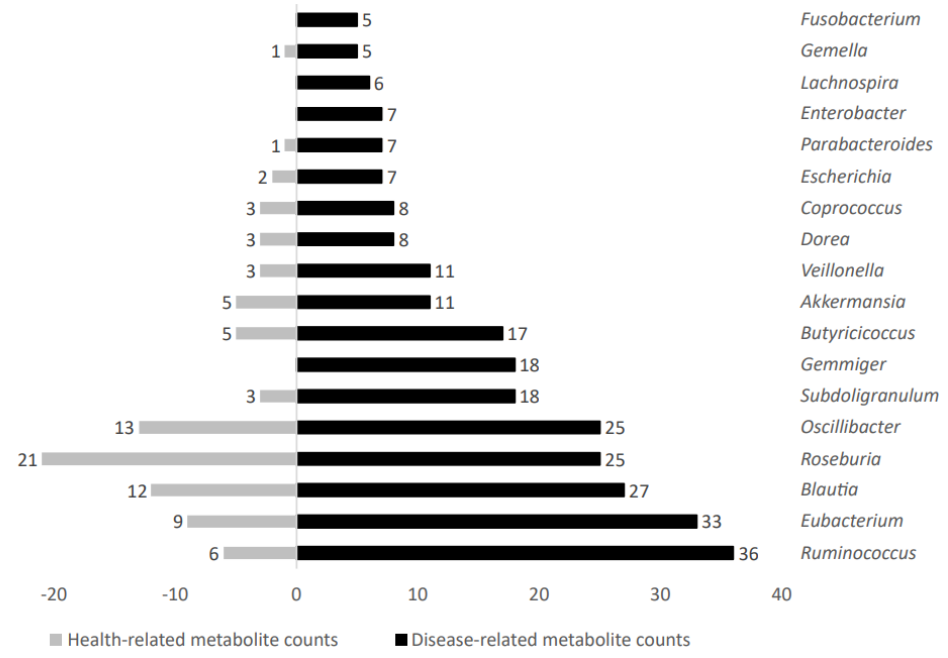
Figure 6. Disease − related metabolite counts stratified according to gut microbiota taxa producers.